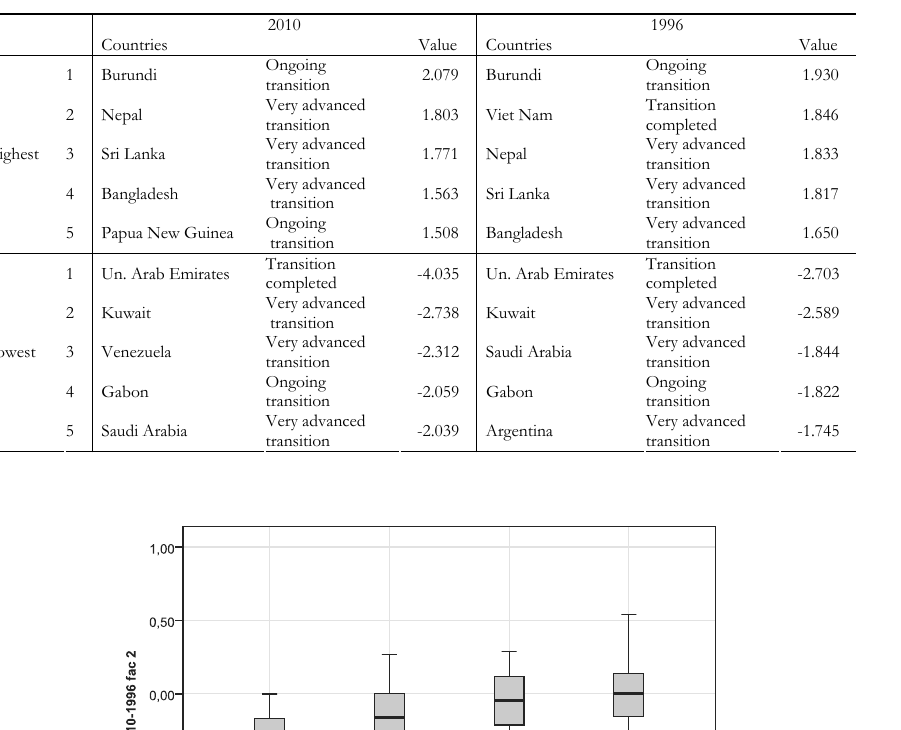
Extreme scores for factor 2 - Macroeconomic conditions and deprivation 2010- 1996